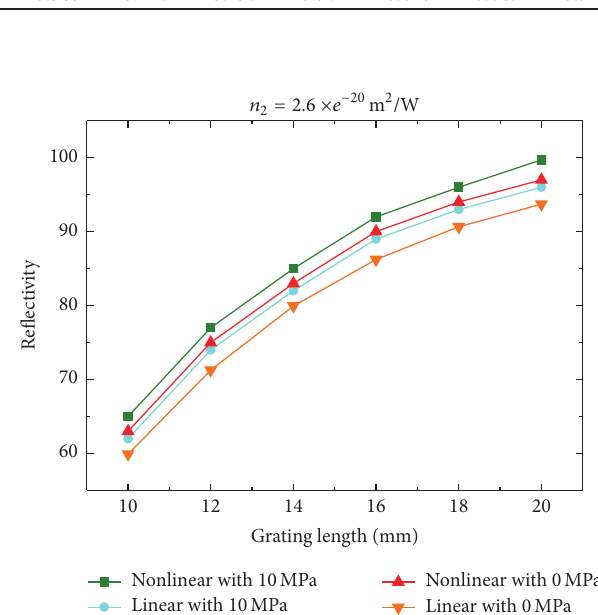
Figure 10: Wavelength shifts due to 300 𝜇𝜀 applied strain.